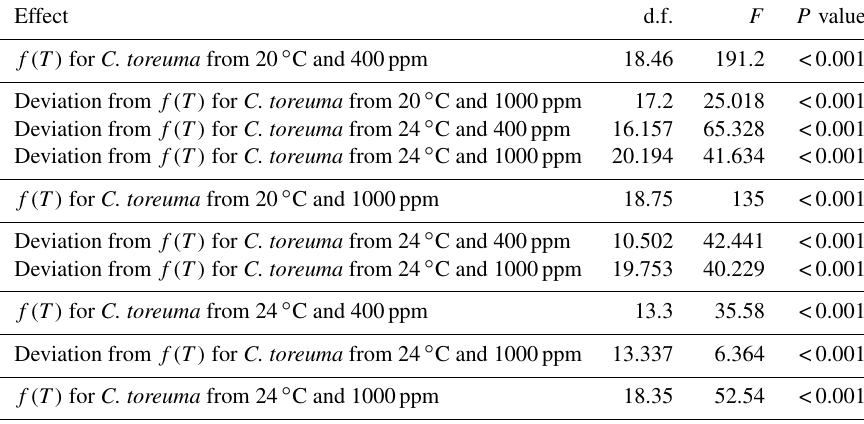
Table A2. Inferential statistics for the most likely general additive mixed models (GAMMs) of heart rate during continuous warming of the limpet Cellana toreuma acclimated at different temperatures (20 and 24 ◦ C) and p CO 2 levels (400 and 1000ppm) ∗